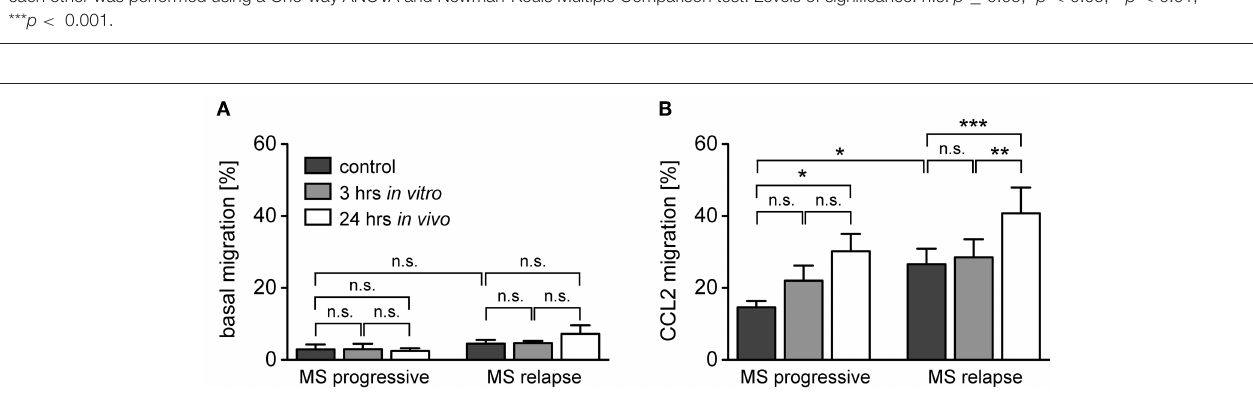
FIGURE 7 | Monocyte migration along a CCL2-gradient in MS patients with progressive disease or an acute relapse under the influence of GCs. The data are the same as in the experiment presented in Figure 4 , but the MS patients are now divided into two groups according to their disease activity. Basal monocyte migration without a chemokine gradient (A) and migration toward a gradient of CCL2 (B) into the lower part of the Boyden chamber were analyzed by flow cytometry and are depicted as the percentage of transmigrated cells (mean ± SEM); n = 4/6 (progressive), n = 9/9 (relapse). For statistical analysis, untreated samples were compared using a t -test and comparison of samples from MS patients to each other was performed using a One-way ANOVA and Newman-Keuls Multiple Comparison test. Levels of significance: n.s. p ≥ 0.05; * p < 0.05; ** p < 0.01; *** p <